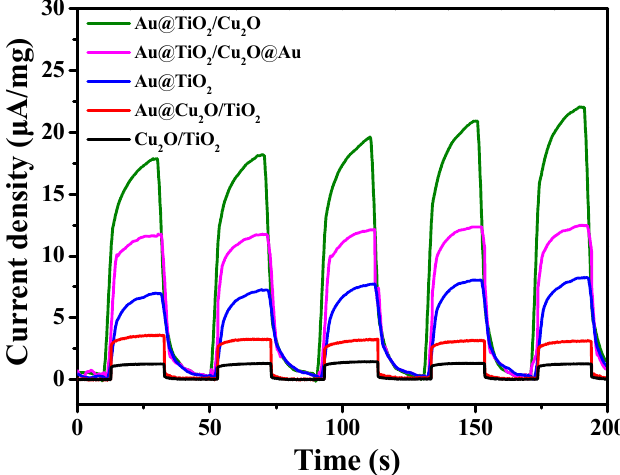
Figure 5. Photocurrent-time traces of photoelectrodes at a bias of 1.23 V vs. RHE under chopped AM 1.5G illumination (100 mW·cm − 2 ), back illumination. Solution: 0.1 M phosphate buffer (pH 7).